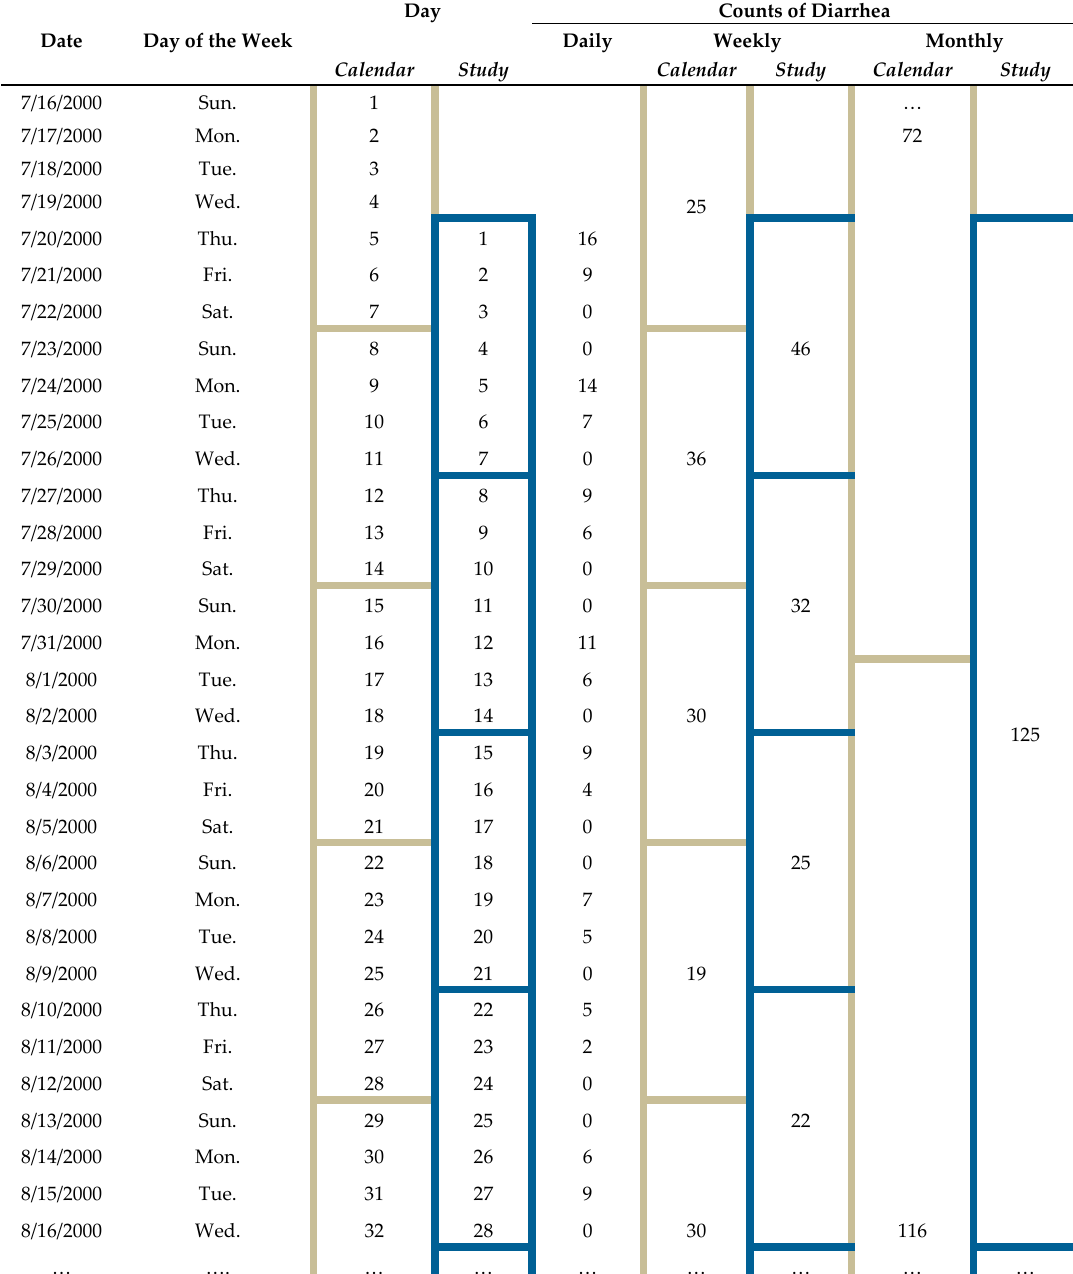
Table 1. Daily, weekly, and monthly disease counts based on a calendar and study time references. Diarrheal counts are shown as an example for the first 28 days for Cohort 1. Blue boxes show the study aggregation scheme, while brown boxes show the calendar aggregation scheme. Day Counts of Diarrhea Daily Weekly Monthly Study Calendar Study Calendar